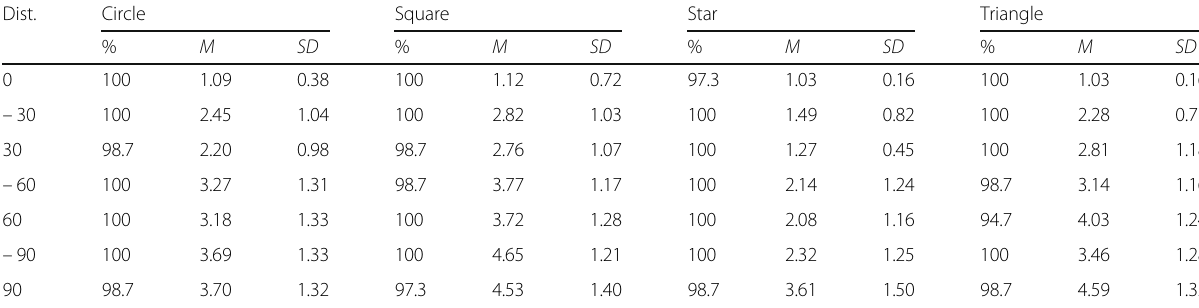
Table 1 Categorization and distortion rating of prototypical and distorted symbols Dist. Circle Square Star